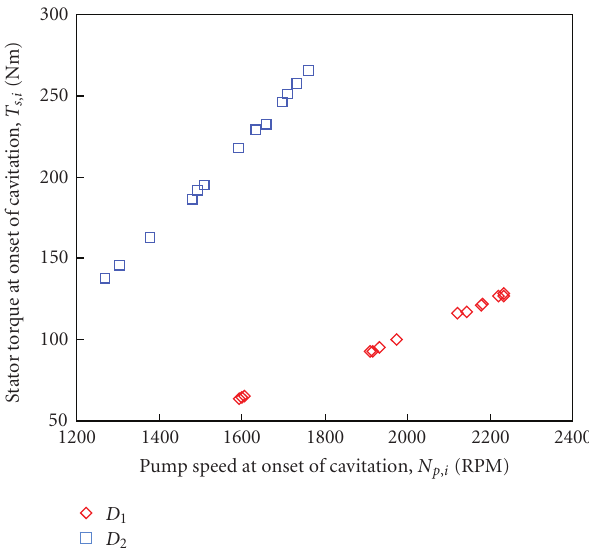
Figure 8: Stator torque at the onset of cavitation plotted against pump speed at the onset of cavitation over all stall operating points.